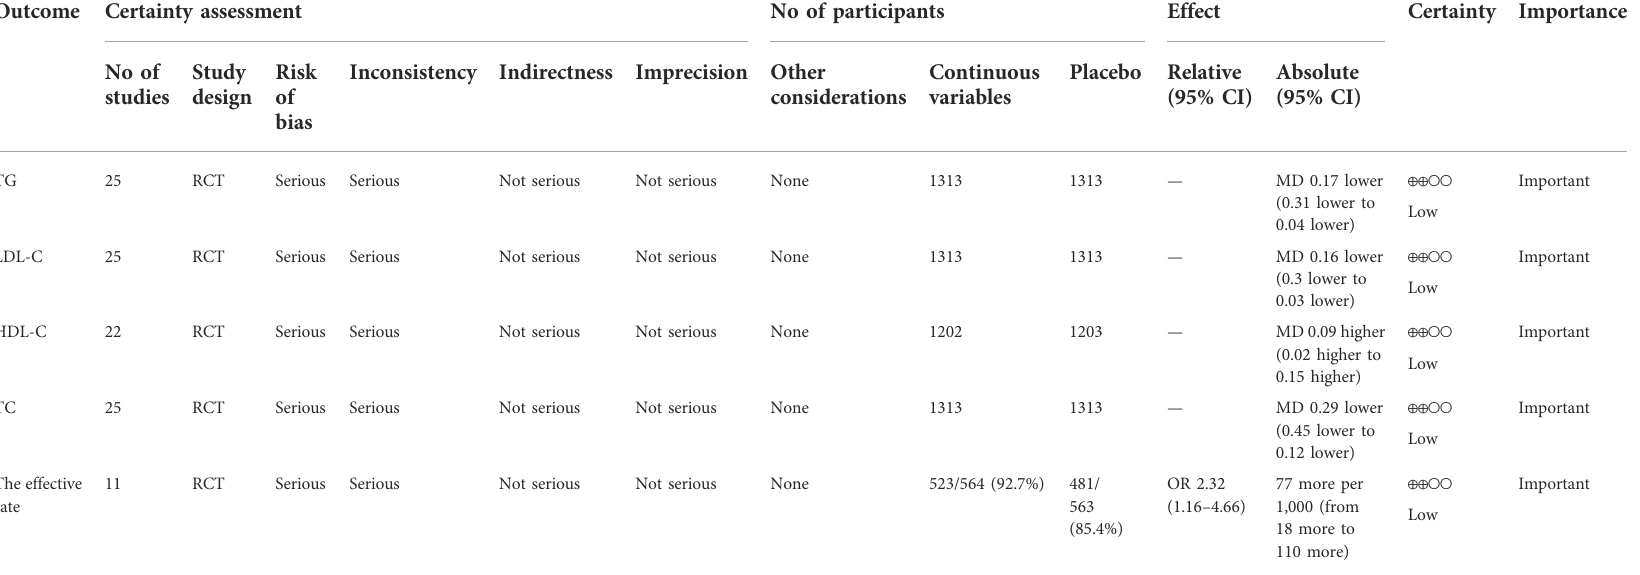
TABLE 6 Summary of the study fi ndings.